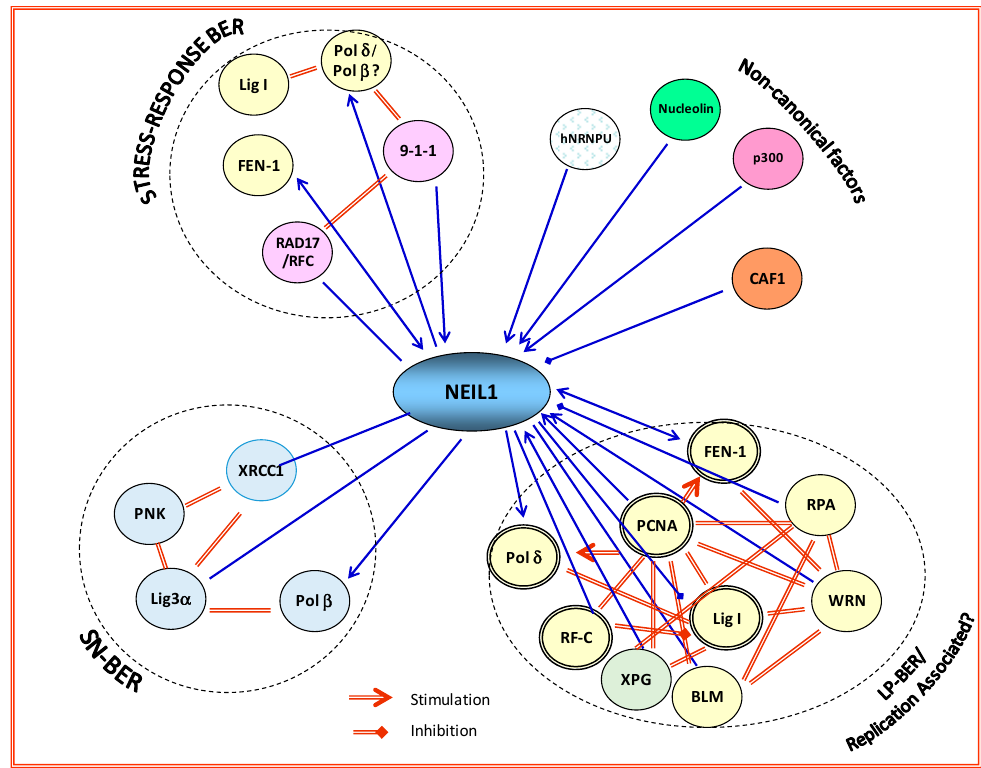
Figure 2. NEIL1 acts as a hub protein in binding to distal partners in BER. NEIL1 forms distinct complexes with single-nucleotide (SN-)BER, long patch (LP-)BER (replication-associated), and other non-canonical proteins, many of which activate its BER activity. RPA inhibits NEIL1 activity in single-stranded (ss)DNA substrates. Binding of nucleolin and p300 are from unpublished data. Pol β : polymerase beta; hNRNP-U: heterogeneous nuclear ribonucleoprotein U; 9-1-1: Rad9–Rad1–Hus1; CAF1: chromatin assembly factor-1; XRCC1: X-ray cross-complementing protein; PNK: polynucleotide kinase; Lig3 α : ligase 3 alpha; Pol β : polymerase beta; XPG: Xeroderma pigmentosum Complementation group G; BLM: Bloom syndrome protein.